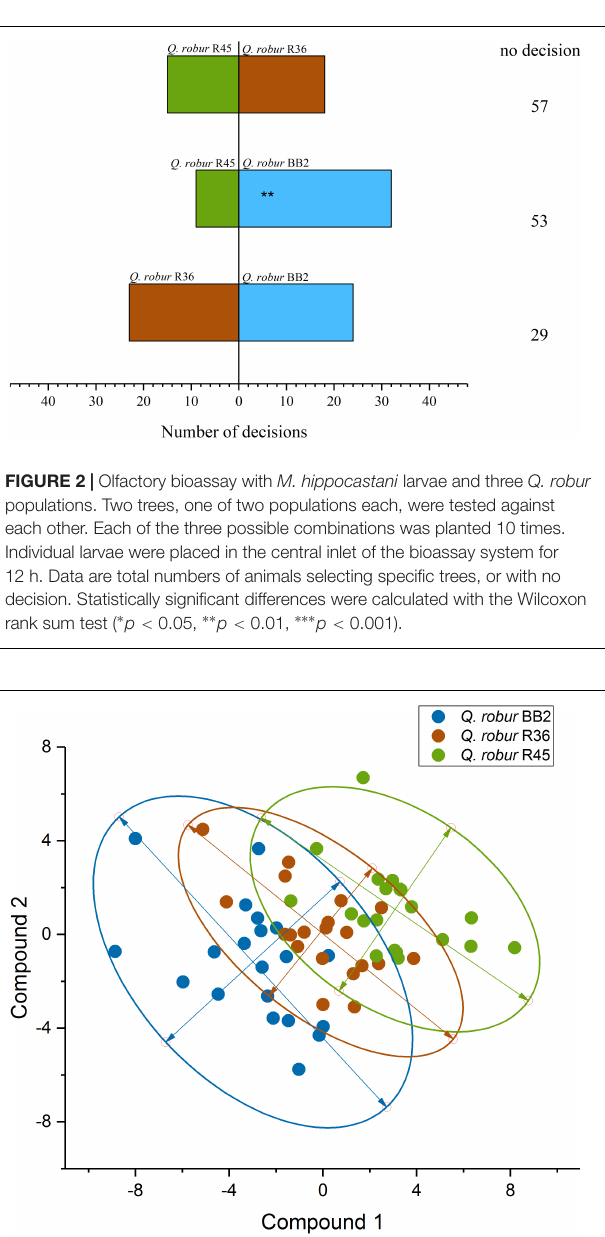
FIGURE 3 | PLS-DA of the VOC patterns in the soil of three different Q. robur provenances ( N = 20). The trees were kept for 3 months on the identical soil substrate and were used for the bioassays (see Figure 2 ). During the bioassays, volatiles abundant in the soil were collected on passive samplers and analyzed by GC-MS. Ellipses indicate the 95% confidence level.